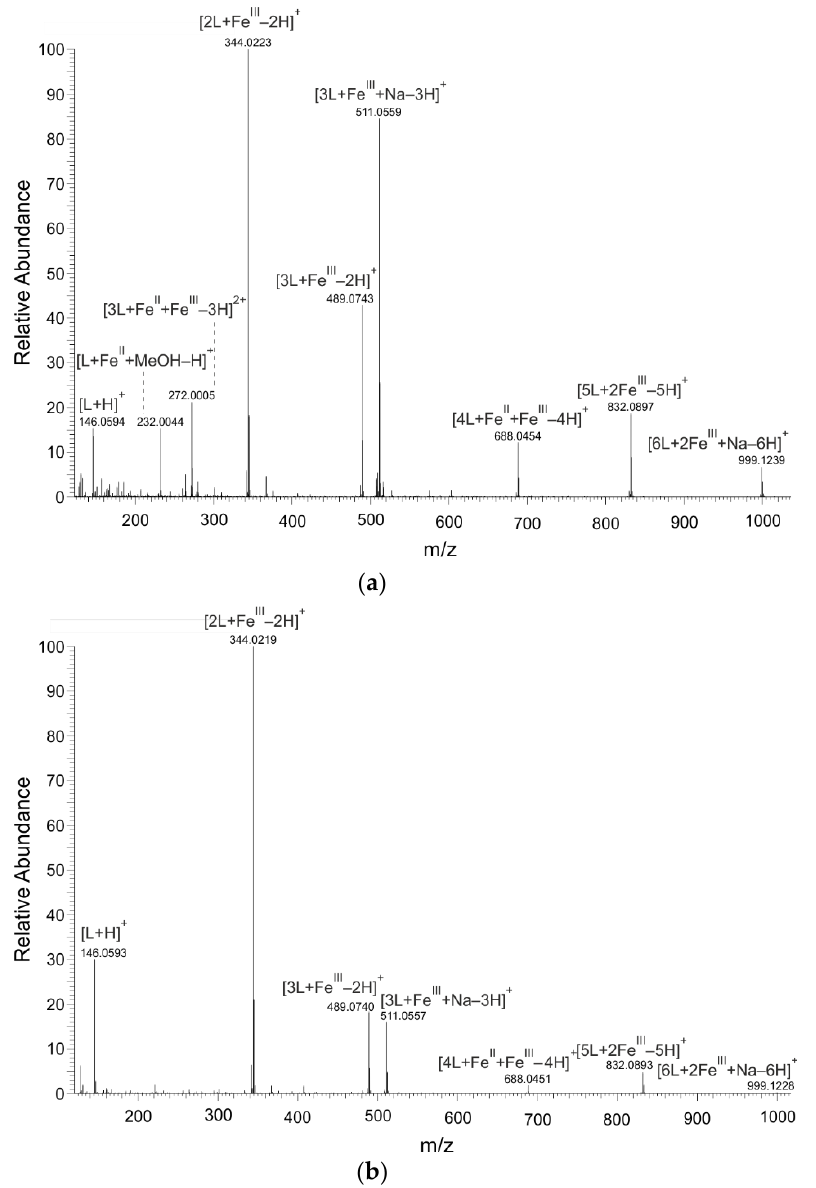
Figure 1. Mass spectra of Fe − 8HQ (L) coordination complexes detected in solutions by nano-ESI − MS (nano-electrospray − mass spectrometry); positive ionization mode. The solutions were prepared by mixing of 8-hydroxyquinoline (8HQ) solution with ( a ) Fe II or ( b ) Fe III solutions in molar ratio of metal to ligand of 1:2.